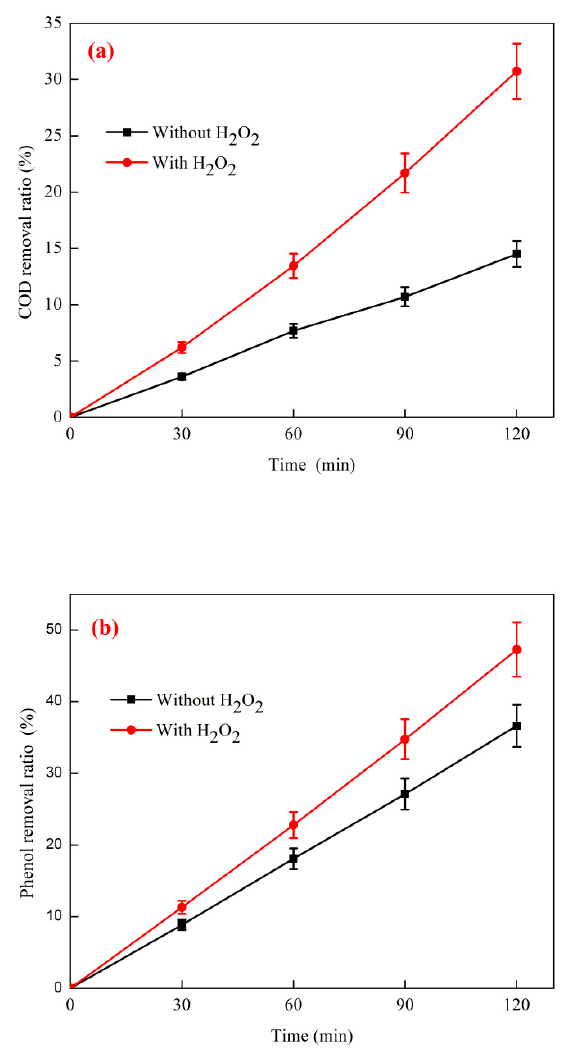
Figure 10. E ff ect of H2O2 on combined process of coagulation + ozone catalytic oxidation: ( a ) COD removal and ( b ) phenol Figure 10. Effect of H2O2 on combined process of coagulation + ozone catalytic oxidation: (a) COD removal and (b) phenol removal.